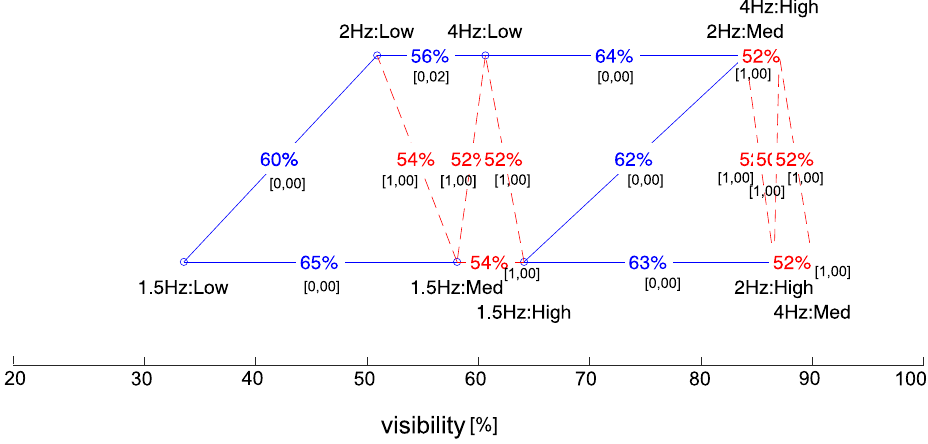
Figure 9. Effect size and ANOVA results: Ranking chart showing the relationship between setups in terms of contrast and flickering frequency.